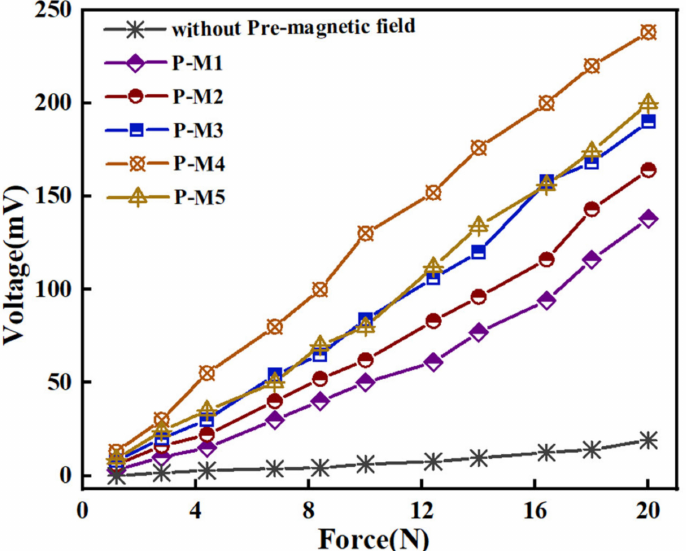
Figure 18. Output voltage of the harvesting device with different pre-magnetized magnetic field